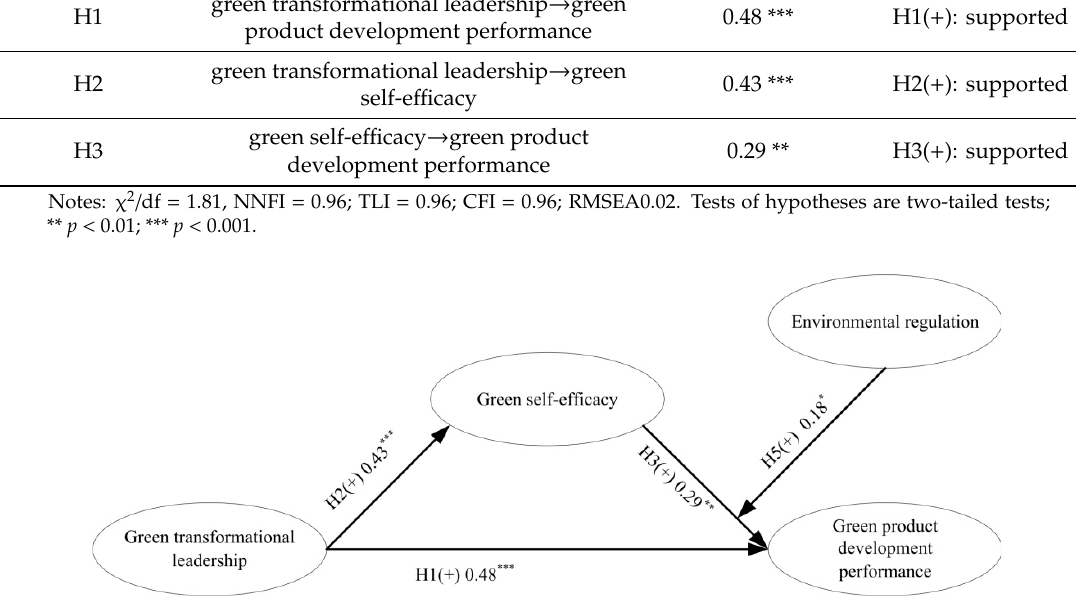
Figure 2. Modelestimationresults. * p < 0.05, ** p < 0.01, *** p <